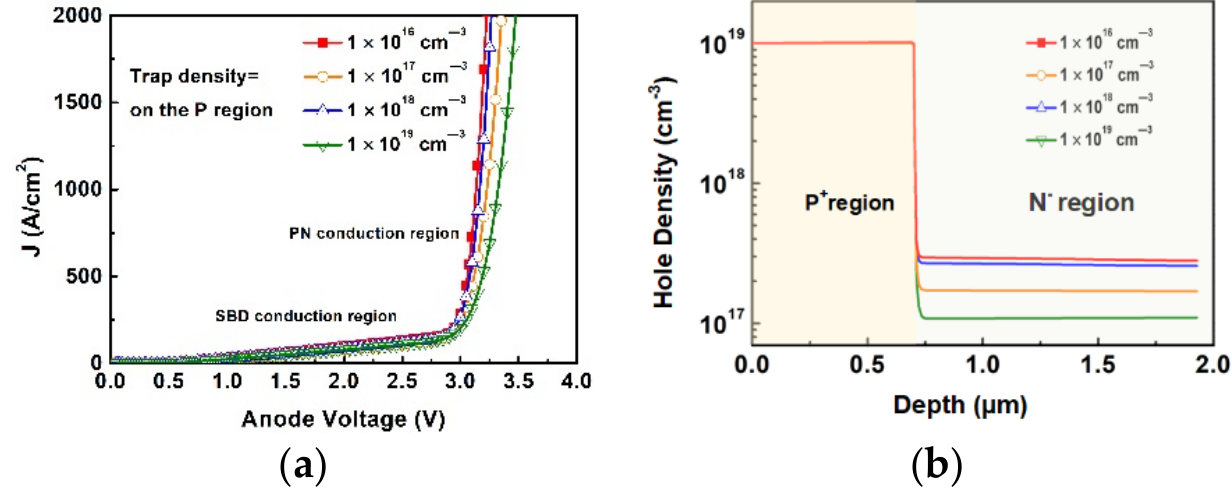
Figure 2. ( a ) The turn-on behavior in transition region with the varied trap density ( b ) hole density distribution in different trap density .